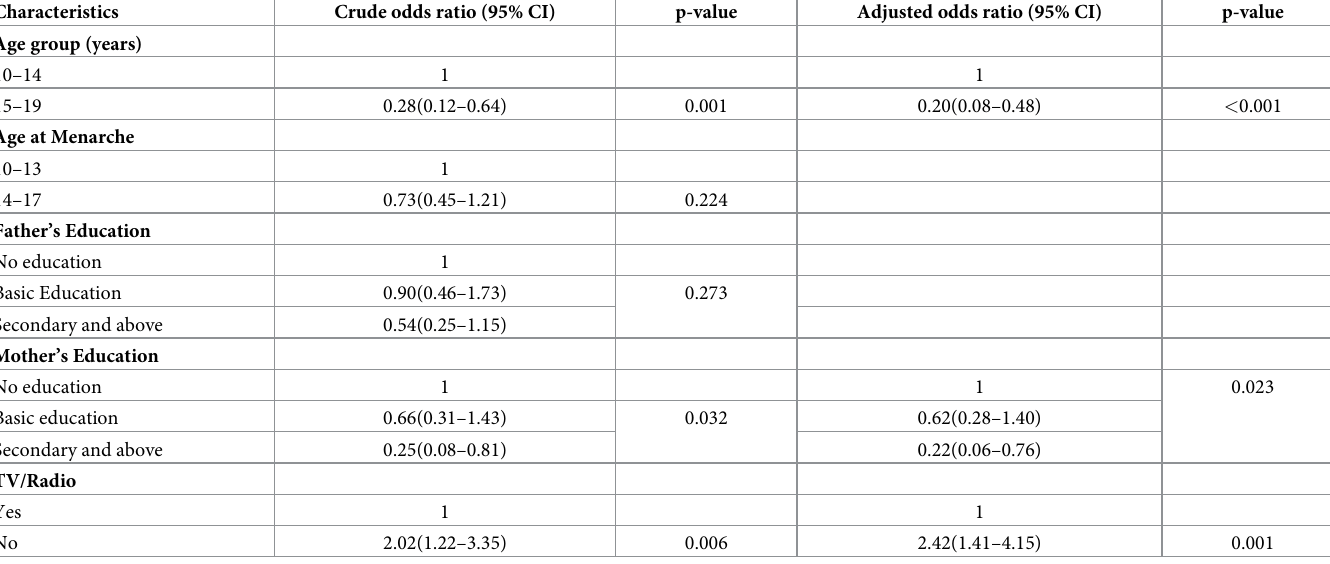
Table 3. Association between sociodemographic characteristics and menstrual knowledge of adolescent girls.